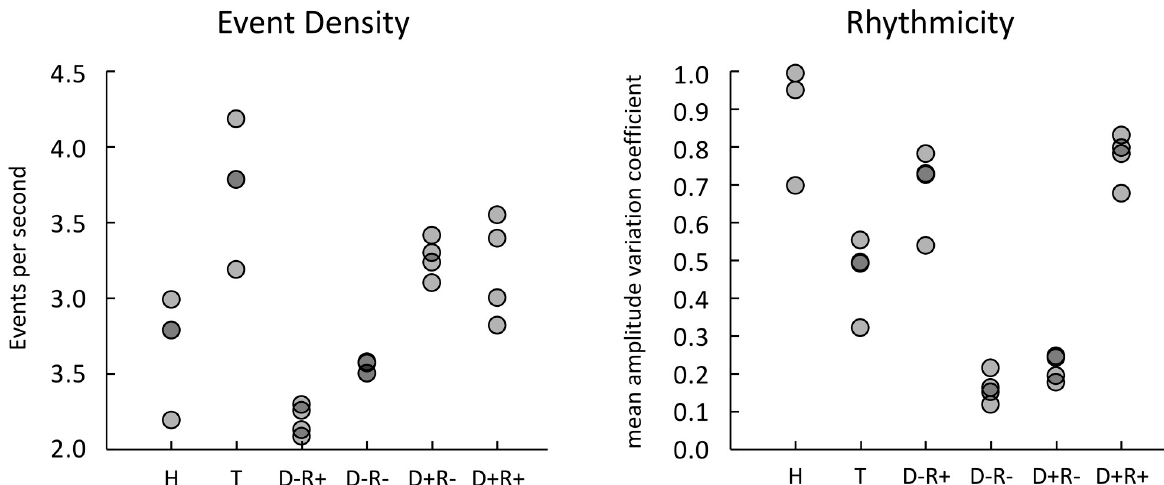
Fig 2. Auditory stimulus features, Study 1 and 2. Left panel shows the event density measured in the videos showing hurdling (H), tap dancing (H) (Study 1) and in the four sub-conditions of the drumming videos implementing combinations of high and low event density (D-, D+) and high and low rhythmicity (R+, R-) (Study 2). Each dot represents one recording. Right panel shows a measure of rhythmicity for the same set of recordings, operationalized as the variability of each recording’s amplitude envelope. Amplitude variation is shown as the coefficient of variation, i.e. the standard deviation of amplitude normalized by mean